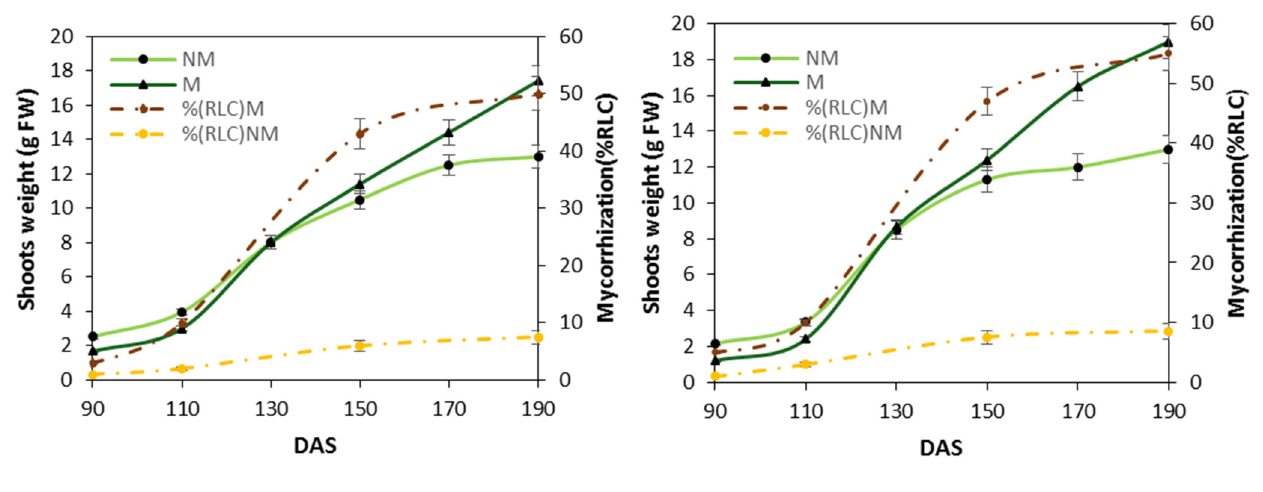
Figure 1. Differences in the aerial biomass weight between mycorrhized and non-mycorrhized plants. Shoot weights (a mean of ten shoots were in each parcel of control (NM) and mycorrhized plants (M)) and the corresponding root length colonization (% RLC) between 90 and 190 days after sowing (DAS) at two separate locations (Larino, Site A; Rotello, Site B). The mycorrhization index (dashed line) is expressed as a percentage of root length colonization % RLC by mycorrhizae. Bars indicate the standard deviation (±SD), and the means are the mean values of ten plants ( n = 10) randomly distributed in the experimental parcel.